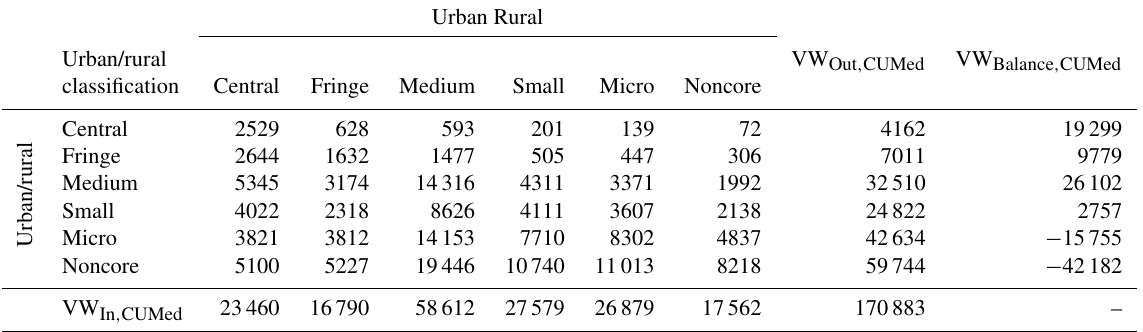
Table 3. Blue virtual water transfers between urban and rural areas (Mm 3